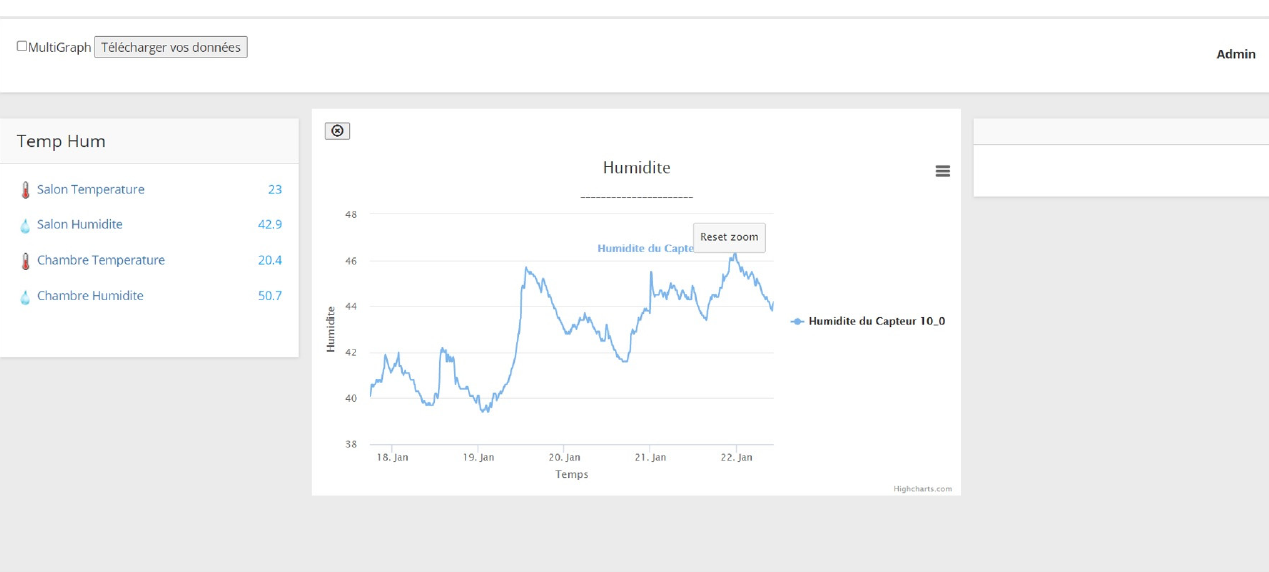
Figure 6. Occupants’ Figure 6. XXX.